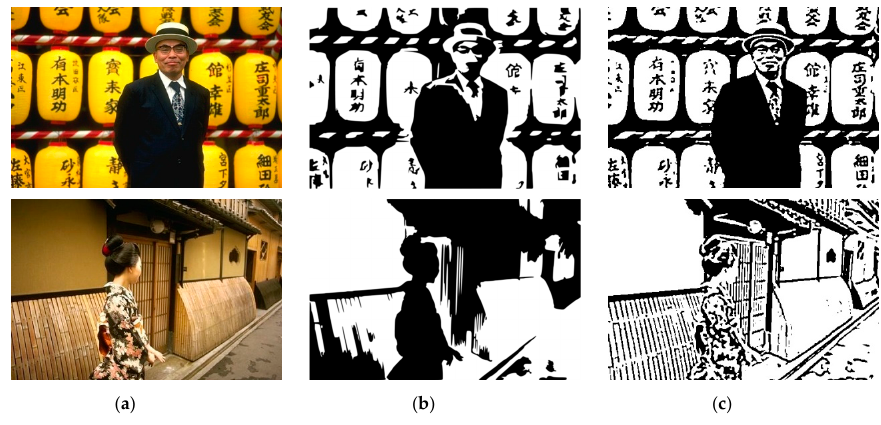
Figure 9. Compared with Artistic Thresholding [25]. ( a ) input ( b ) Xu and Kaplan [25] ( c ) our result.